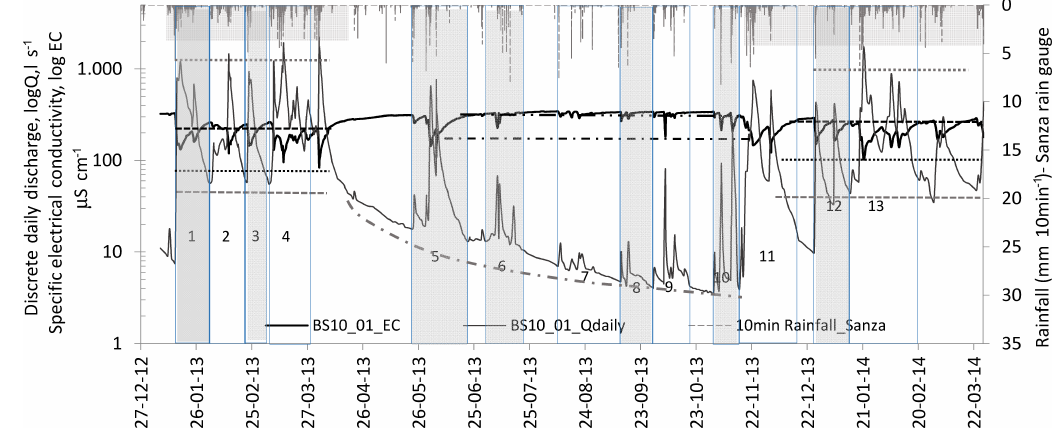
Figure 2. Plot of the hydro-chemograph data set recorded at the main monitoring station (BS16_01) and the 10min rainfall plot at the Sanza rain gauge (from Cuomo and Guida, 2016). Legend: numbers indicate the selected events; horizontal lines are representative of the reference parameter ranges; black dashed-double dot lines indicate EC maxima in the dry period; the black dashed-dot line represents EC minimum during the dry period; the black dashed line indicates EC maxima in the wet period; the black dotted line represents an EC minimum in the wet period; the gray dashed line indicates the Q minima in the wet period; the gray dotted line indicates the average Q maximum in the wet period; finally, the gray dashed-dot curve indicates the theoretical annual baseflow curve of the catchment during the period under consideration.